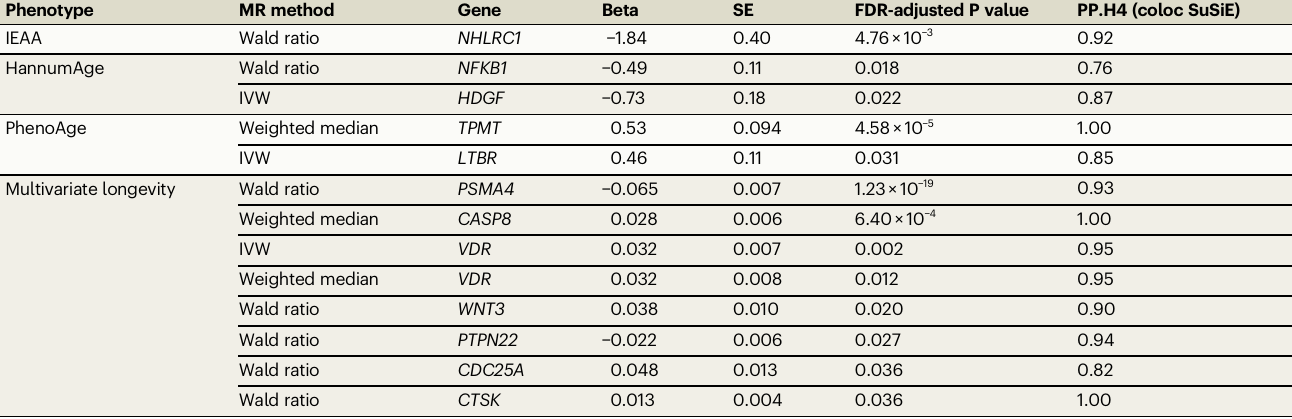
Table 2 | MR of the druggable genome identi fi es genes associated with aging phenotypes